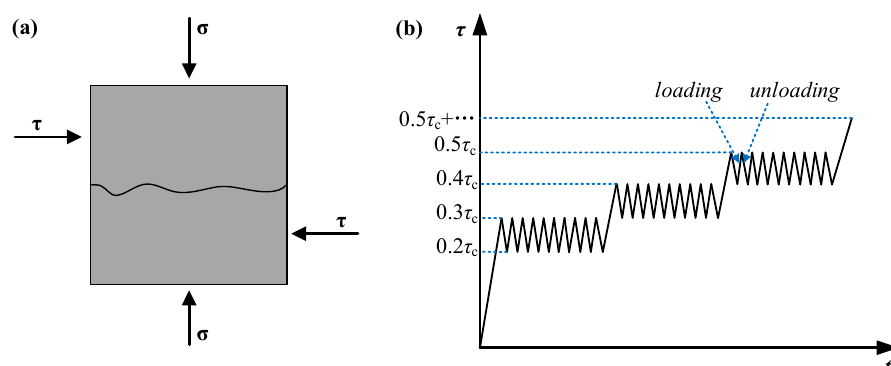
Figure 3. ( a ) Sample loading diagram; ( b ) schematic diagram of test loading path ( σ is the normal stress and τ is the shear